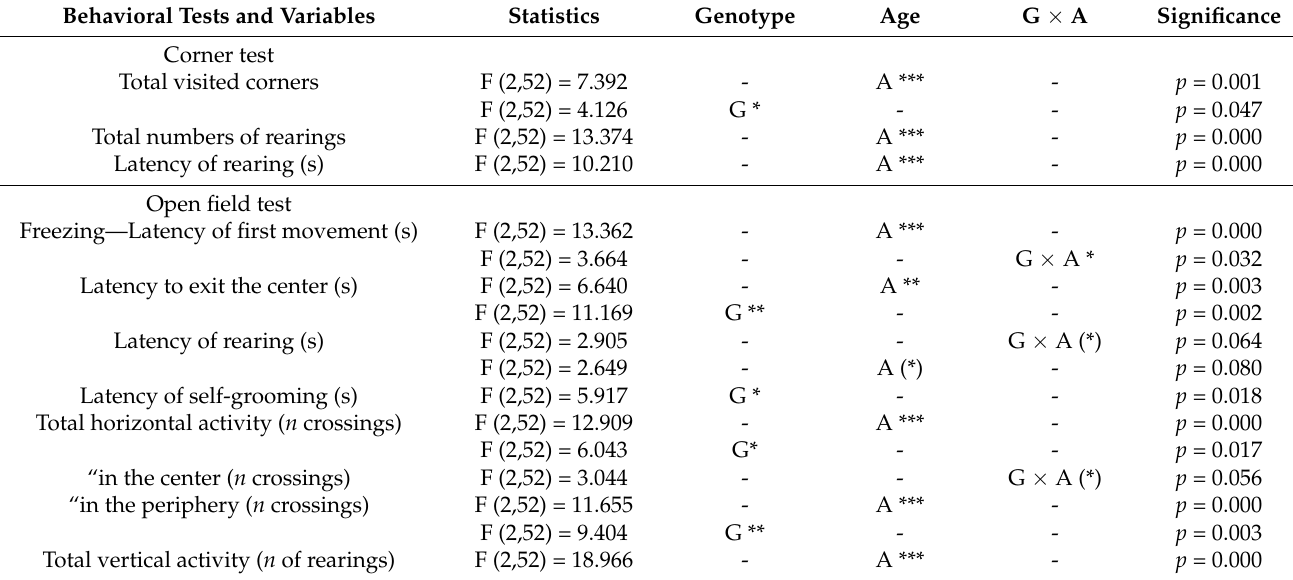
Figure 1. Survival—Effect of age and AD-genotype on survival. Data are expressed by mean and 95% CI, or percentage. Table 1. Genotype and age factors and interaction effects on behavioral tests and variables from middle-age to